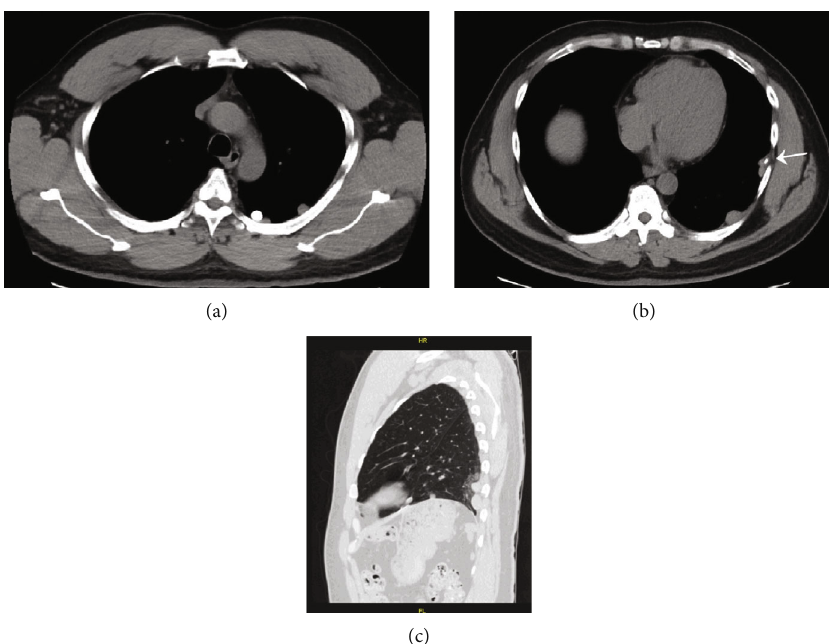
Figure 2: Computed tomography of the chest without contrast. (a) Axial view, mediastinal window at the level of the aortic arch reveals three pleural based nodules one of which is densely calci fi ed, round, and smoothly marginated. (b) Axial view, mediastinal window of the lower thorax shows two pleural based smoothly marginated nodules of soft tissue density, one of which is partially calci fi ed and lobulated (white arrow). (c) Sagittal view, lung window of left hemithorax showing four non-calci fi ed pleural based nodules, one of which is lies along the left major fi ssure. Note the absence of the spleen.